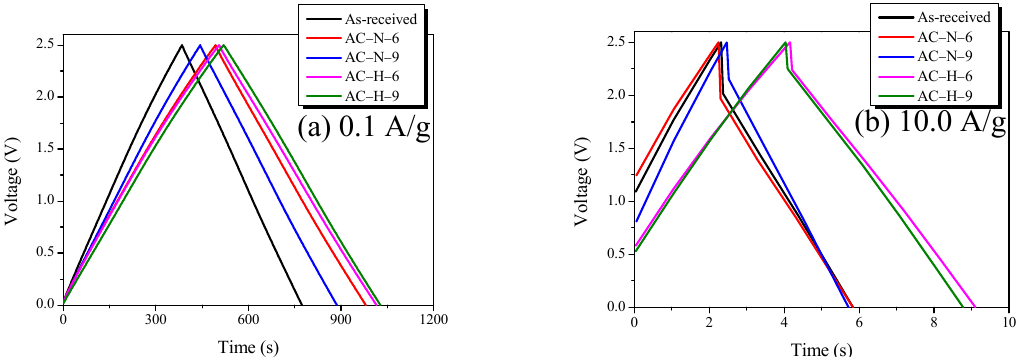
Figure 8. Galvanostatic charge–discharge curves of AC heat-treated under different conditions: ( a ) 0.1 A/g; ( b ) 10.0 A/g. Table 3. Specific capacitance under different current densities of heat-treated